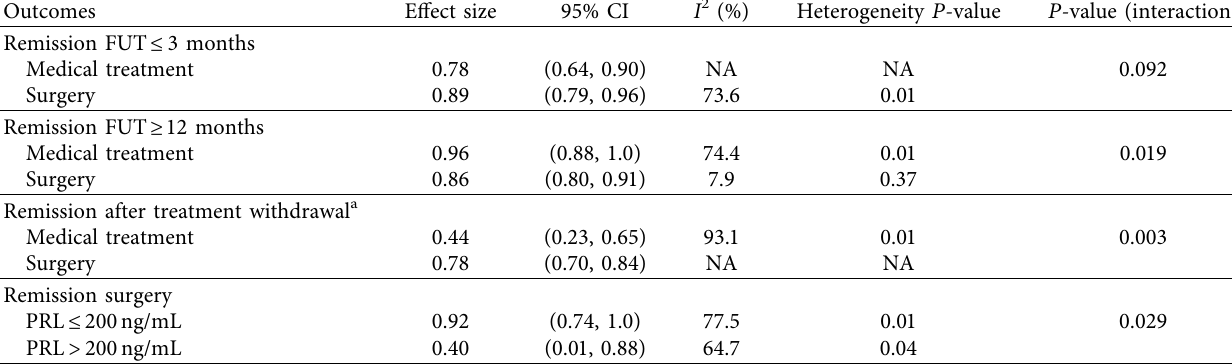
Table 2: Meta-analysis of remission rates as compared between surgery and medical treatment. Meta-analysis showed that there is no significant difference between the surgery group and medical treatment at short-term follow-up (89% vs. 78%; P � 0 . 092). The DA treatment group achieved a higher remission rate at ≥ 12 months follow-up (96% vs. 86%; P � 0 . 019). However, surgery achieved a higher remission rate after treatment withdrawal (78% vs. 44%; P � 0 . 003). Subgroup analysis of surgical cohort revealed that patients with